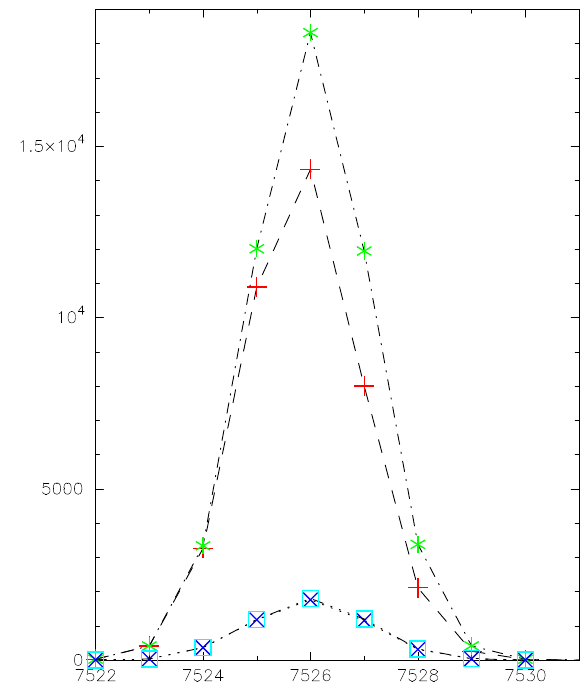
Figure 1. Effects of dead time in COSIMA. The effect is shown for two artificial Gaussian lines. The strongest line has a total yield of 50%. The fainter line has a yield of 5%. The top-most curve (green stars and dot-dash line) shows the original 50% curve; the second curve (red crosses, dash line) shows how the dead-time ef- fect has changed the curve. This is in principle the observed line. Note how the maximum and correspondingly the total line counts have decreased. Also note how the line center and peak have shifted to the left. This is particularly noteworthy on the right side of the line. The lower two curves show similar cases for the 5% line with blue squares and purple crosses,